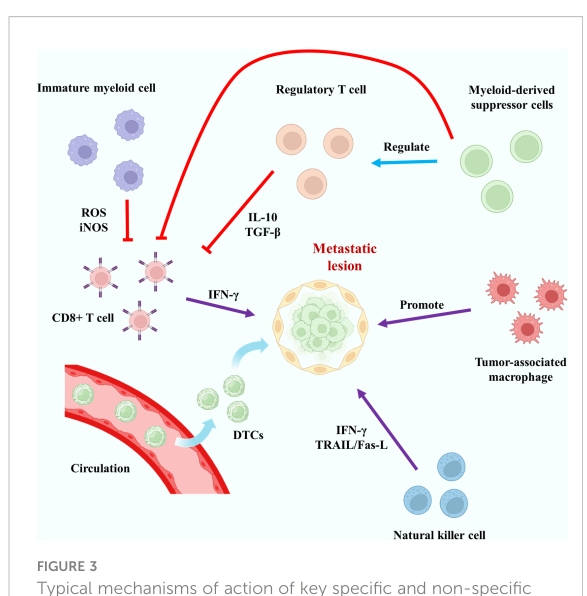
FIGURE 3 Typical mechanisms of action of key speci fi c and non-speci fi c immune cells in bone metastases. The red lines represent inhibitory